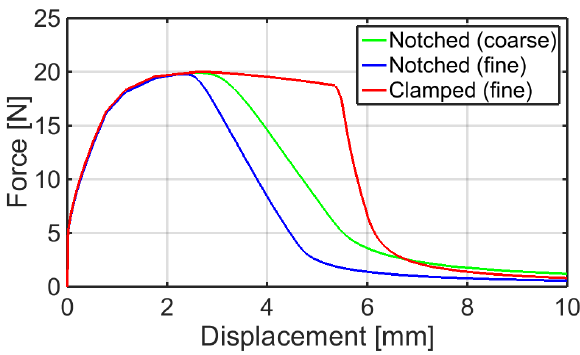
Figure 10. Overall load-displacement curves resulting from the simulation of uniaxial tensile tests of aluminum laminates in the hypothesis of perfect adhesion among the components.